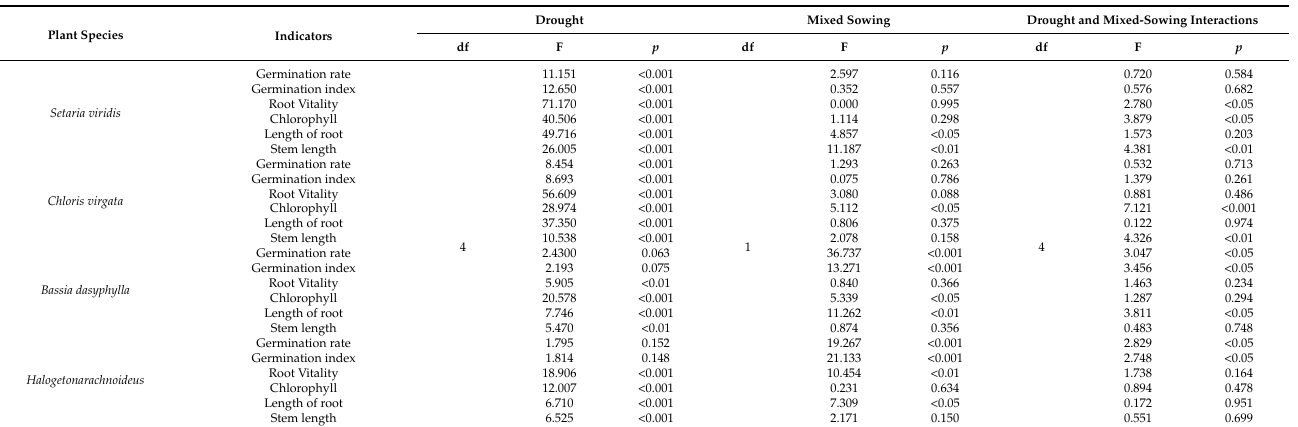
Table 2. Two-way ANOVA analysis of the response of four annual desert plants to drought and mixed sowing interactions.